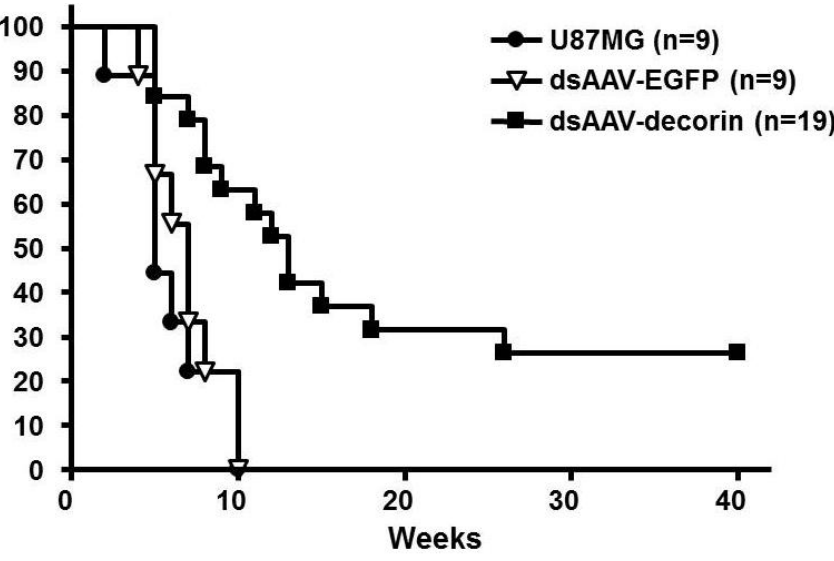
Figure 4. Co-delivery of dsAAV-decorin viral particles with U87MG cells results in a long-term survival of the nude mice that received U87MG cells. U87MG cells (5 × 10 5 ) alone or tumor cell mixed with dsAAV-decorin vectors were co-injected i.c. into the brain of nude mice. Among all groups, none of the mice died until three weeks after tumor cell implantation. Afterwards, mice that received U87MG cells ( n = 9) and